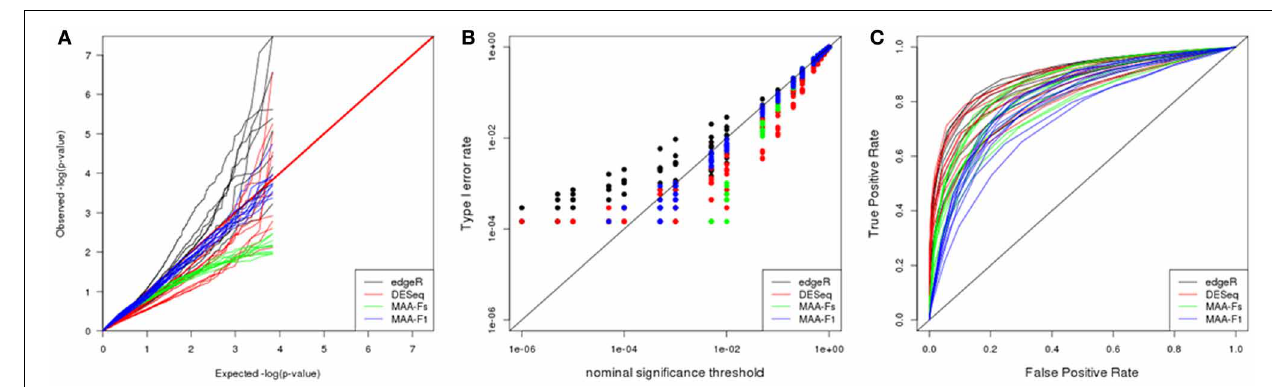
FIGURE 7 | Plasmode results from Bottomly dataset: (A) Q-Q uniform plot of non-differentially expressed transcripts, (B) type I error rate vs. nominal significance values, and (C) ROC curves. Models: (1) edgeR